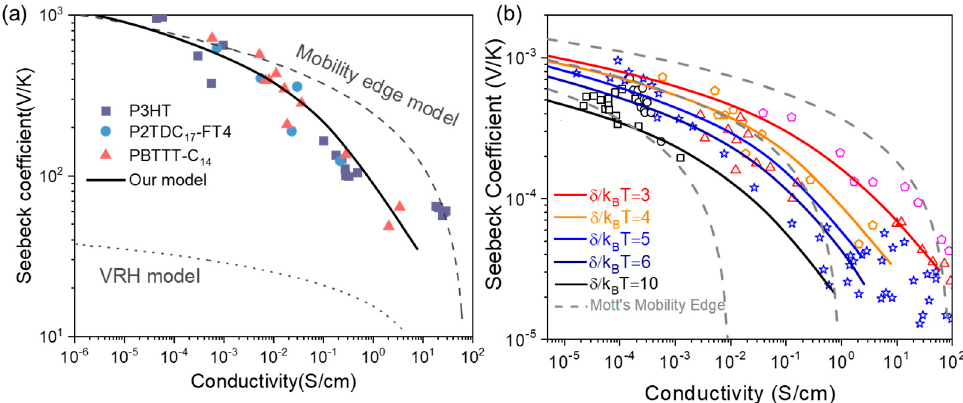
Figure 4. Relationship between conductivity and Seebeck coefficient: ( a ) comparison of fitting results between our model and Mott’s VRH / ME model including P3HT, P2TDC 17 -FT4, and PBTTT-C 14 ; ( b ) fitting between theory in this work and experimental data given by the literature, including P3HT:F4TCNQ mixed P3HTT film (black squares and black circles), polyacetylene (blue stars), PBTTT film (orange pentagons and red triangles), and PEDOT:PSS (magenta pentagons). The experimental data from P3HT, PBTTT, polyacetylene, and PEDOT:PSS are